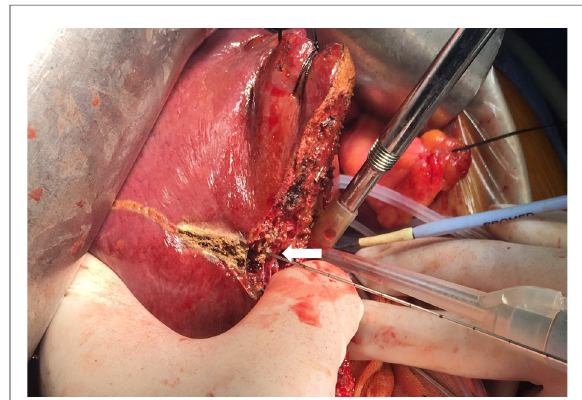
FIGURE 3 Intraoperative view showing parenchyma transection by a CUSA guided by the inserted needle (arrow) in a patient receiving left semi-hepatectomy.